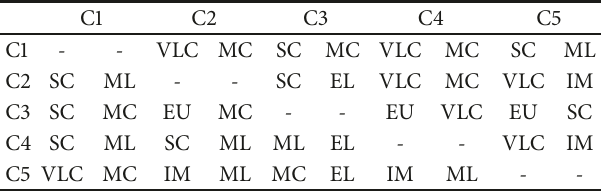
Table 6: Collective evaluation with fuzzy relation